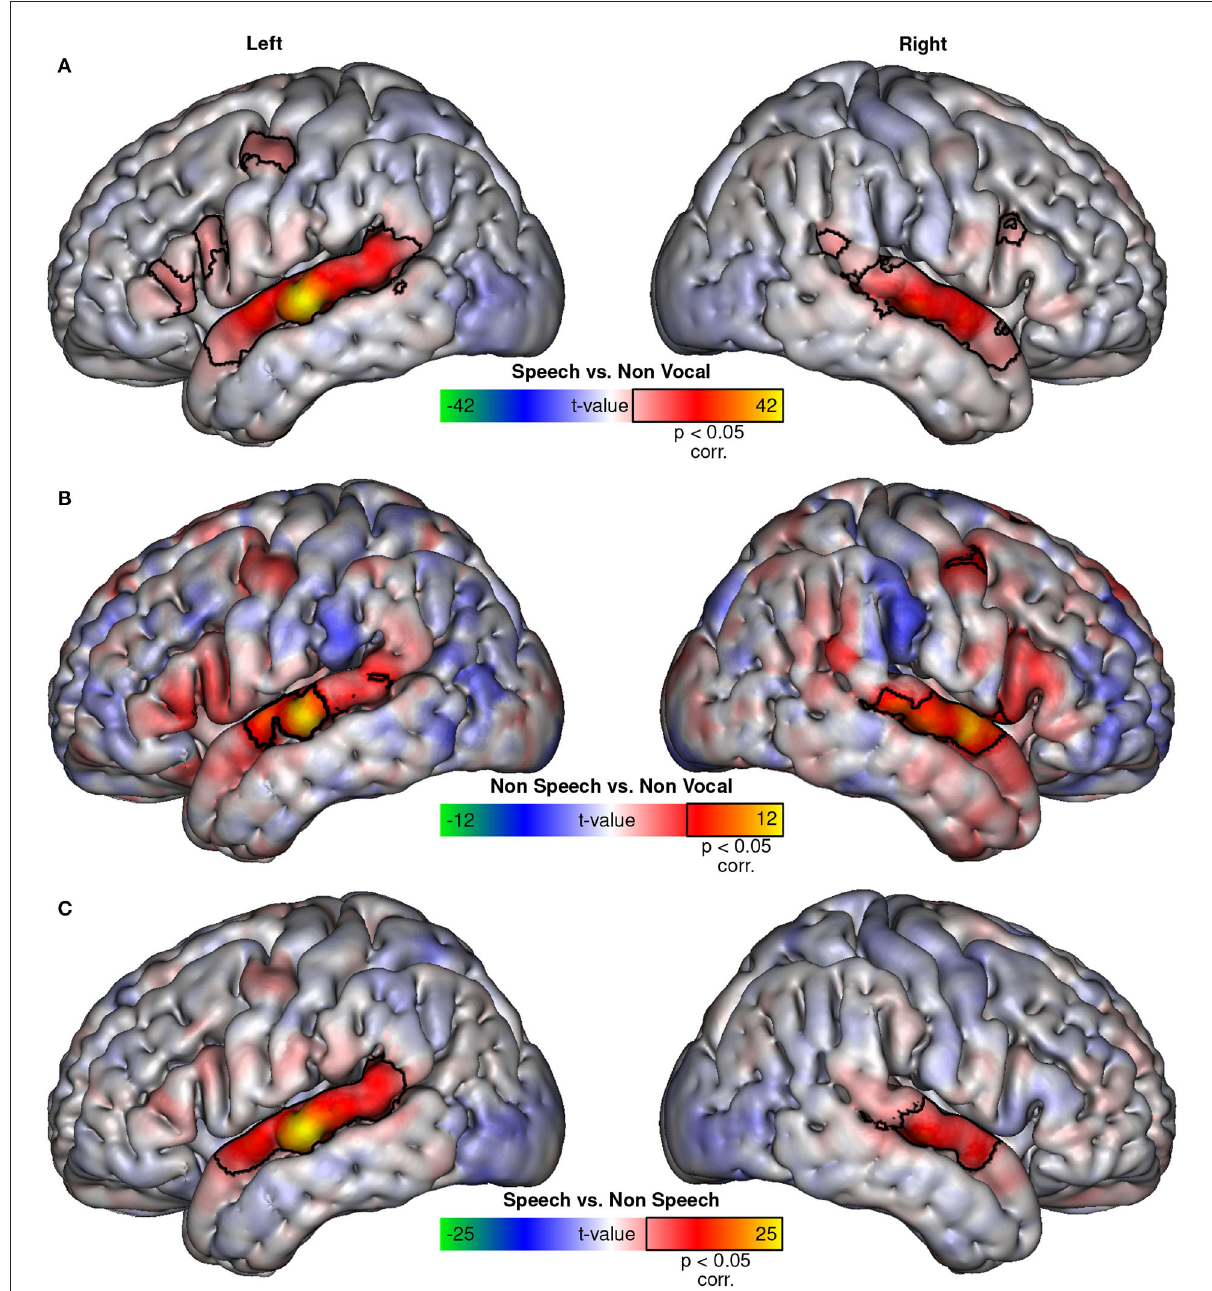
FIGURE1 BOLD activations. Fixed-effects t-maps projected on the MNI152 surface of the speech vs. non-vocal contrast (A) , non-speech vs. non-vocal contrast (B) , and the speech vs. non-speech contrast (C) . Colormaps were adjusted to be symmetrical, with limits corresponding to the maximal t -value in each contrast. Areas with significant ( p < 0.05, corrected) activation to each contrast are outlined in